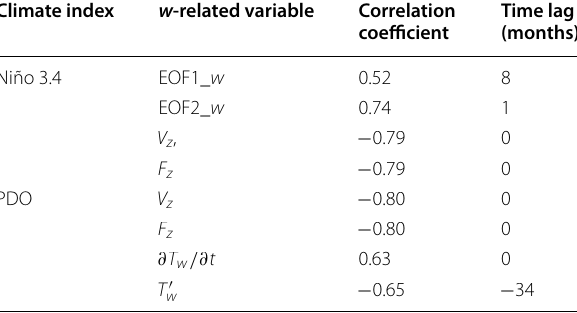
Table 1 Correlation coefficients of the first and second